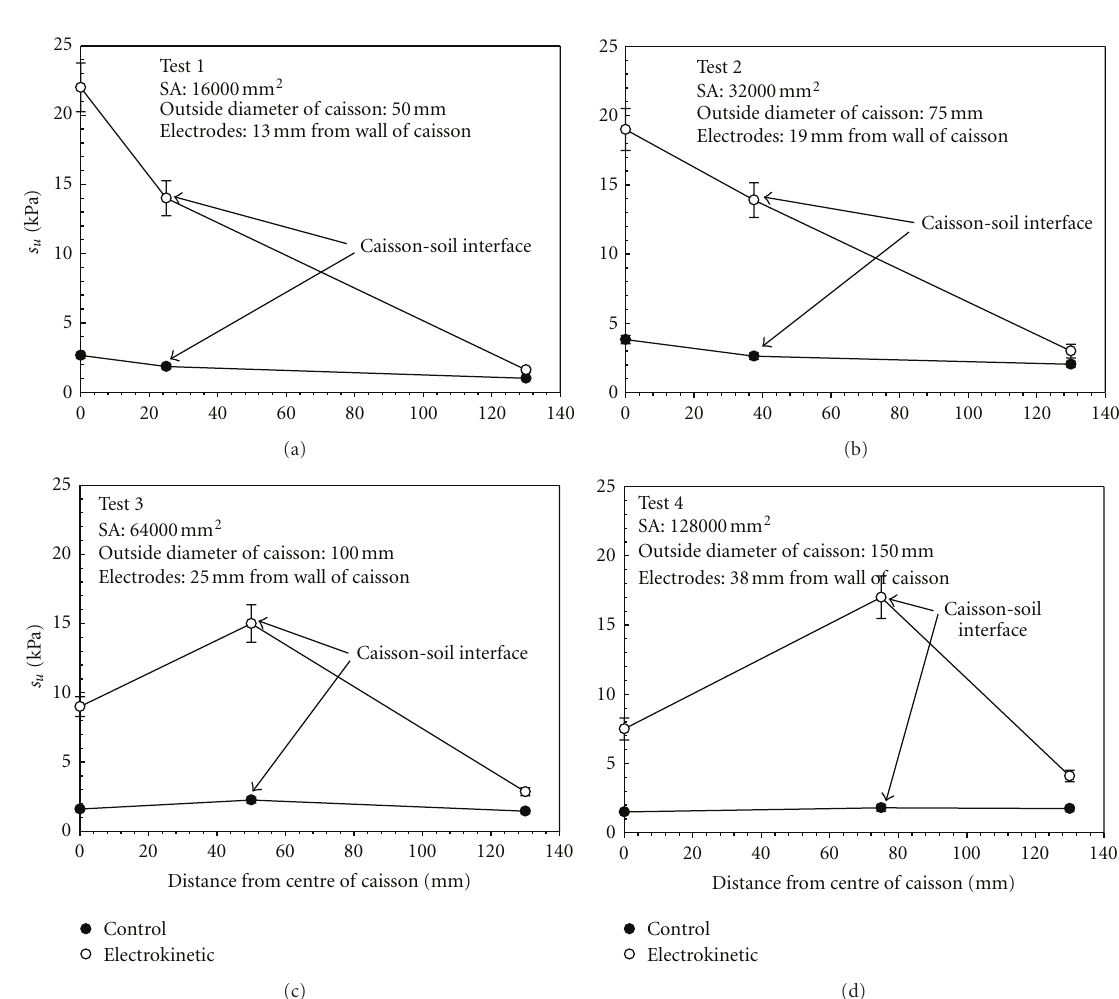
Figure 5: Undrained shear strength, s u , versus distance from the centre of model